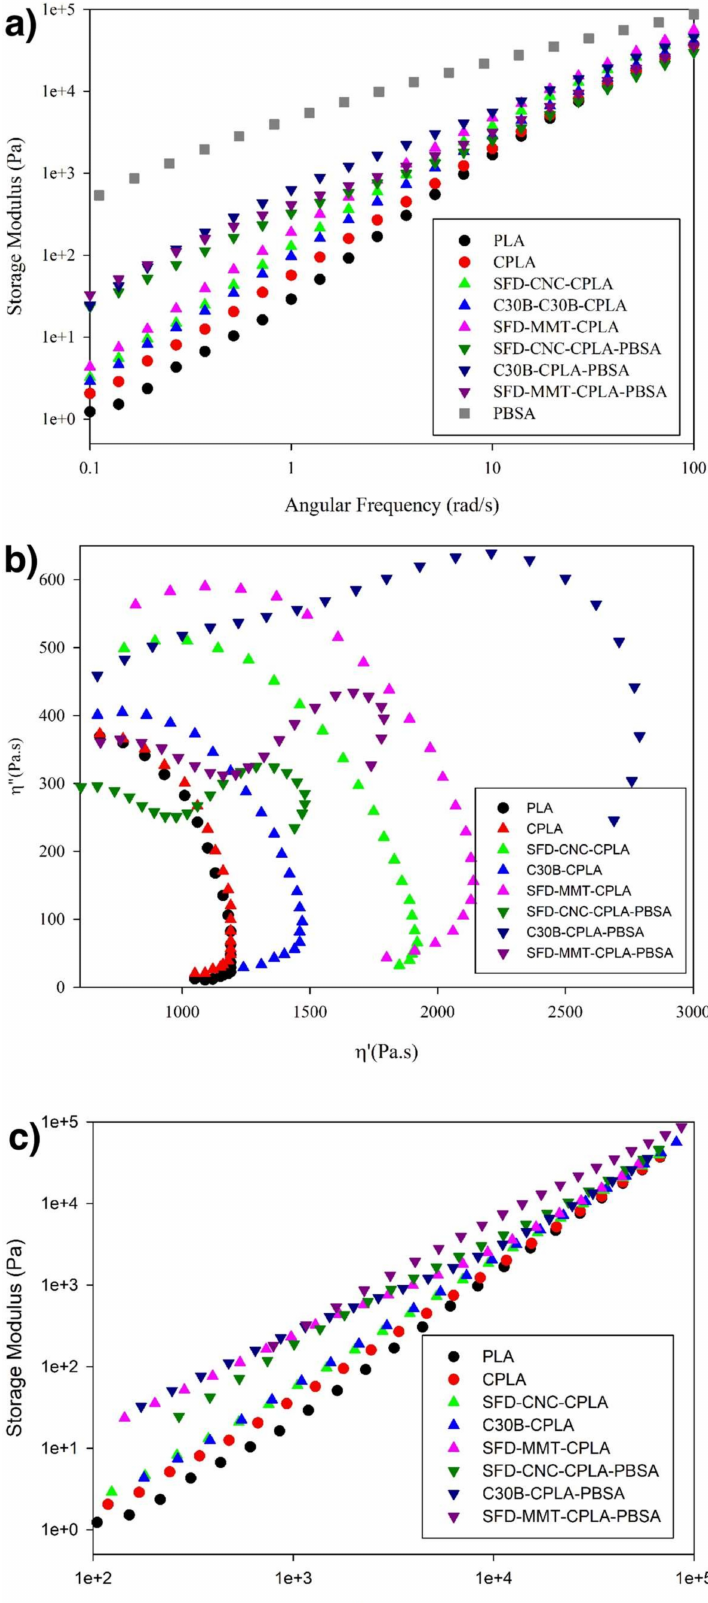
Figure 6. ( a ) Storage modulus, ( b ) Cole–Cole plot and ( c ) modified Cole–Cole plot of the pure components, PLA nanocomposites and their corresponding PLA-PBSA blends and